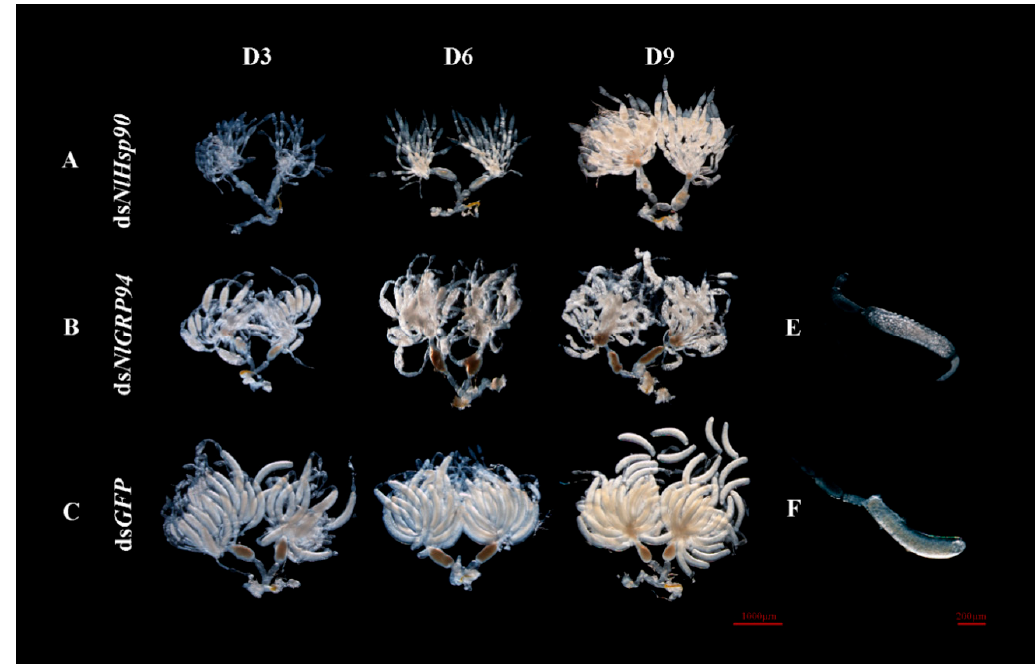
Figure 7. Phenotypes of ovary development upon gene knockdown. ( A – C ) Ovaries dissected from ds Hsp90- , ds NlGRP94- and ds GFP -treated females at 3, 6 and 9 days after adult eclosion. ( D3 ), ( D6 ) and ( D9 ) represent day three, day six and day nine of the ovary. ( E ) An oocyte from the ovaries of ds NlGRP94 -treated females. ( F ) An oocyte from the ovaries of ds GFP -treated females.